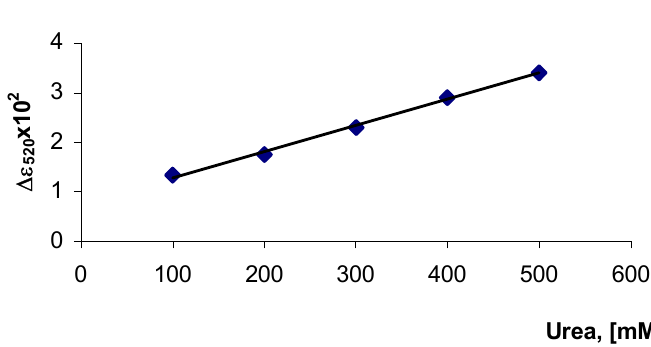
FIGURE 6. Standard curve for determination of the amount of urea using both enzyme and indicator immobilized on a triacetylcellulose membrane.